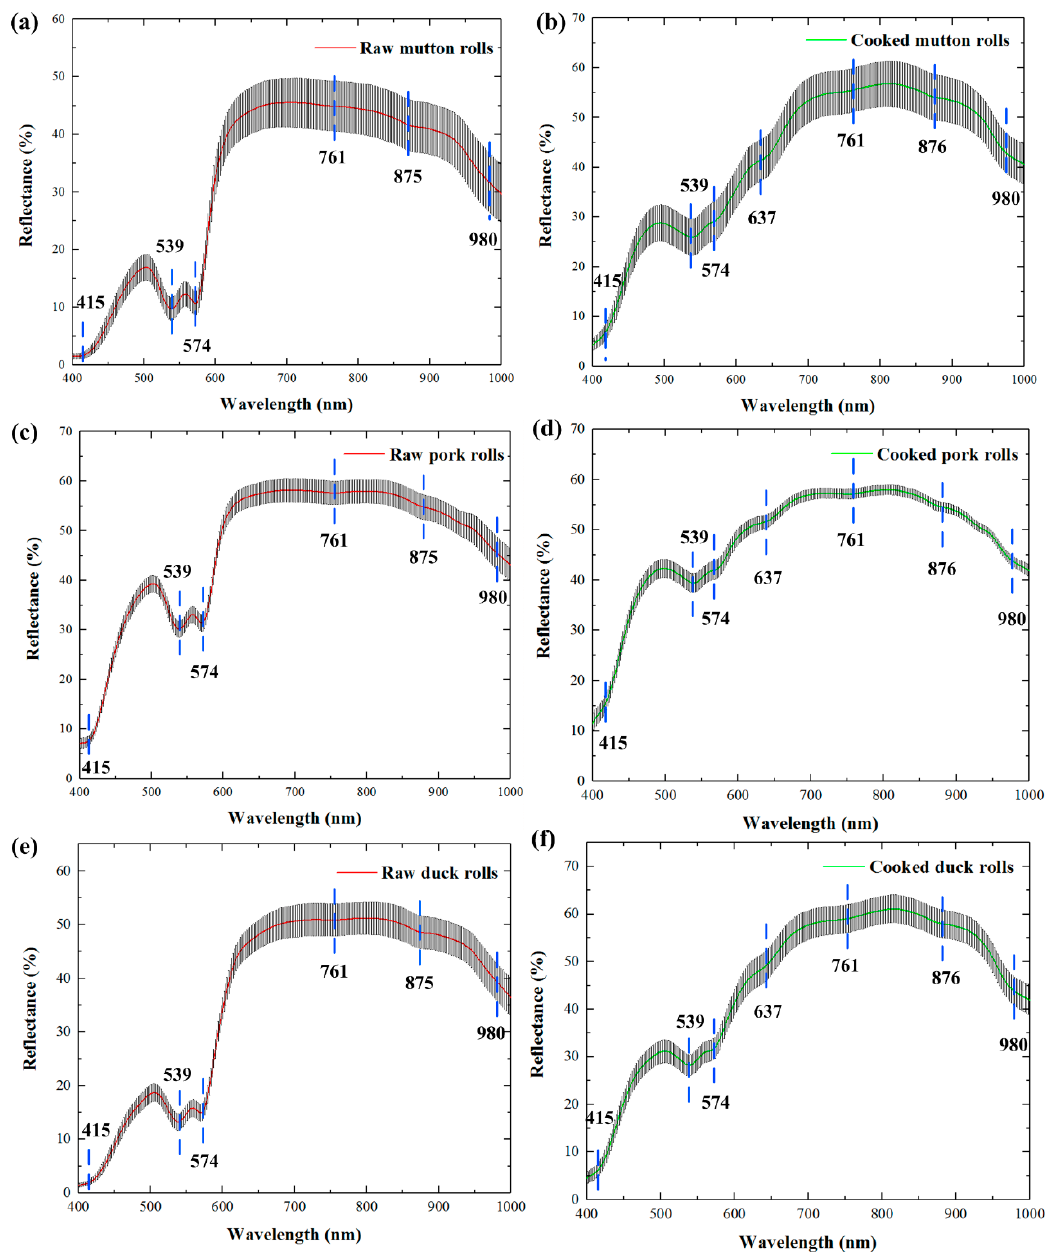
Figure 2. The average reflectance spectra with standard deviation (SD) for raw and cooked meat rolls of mutton ( a , b ), pork ( c , d ), and duck ( e , f ).